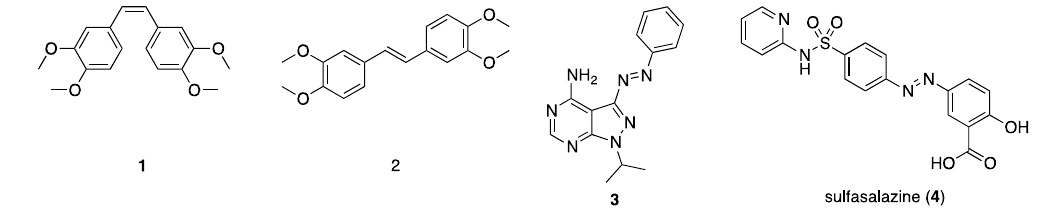
Figure 1. Chemical structures of compounds used in this